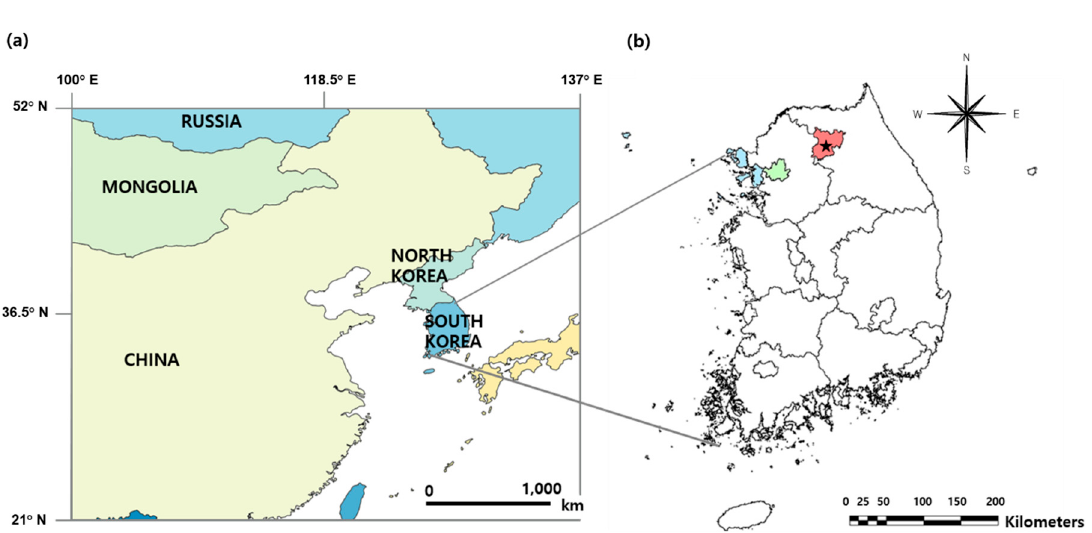
Figure 1. Study area. ( a ) Location of South Korea. ( b ) Map of South Korea. The red area represents the city, Chuncheon, while the star represents the location of the sampling site; moreover, the green and blue areas represent the capital of South Korea (Seoul) and the major industrial regions (Incheon), respectively.